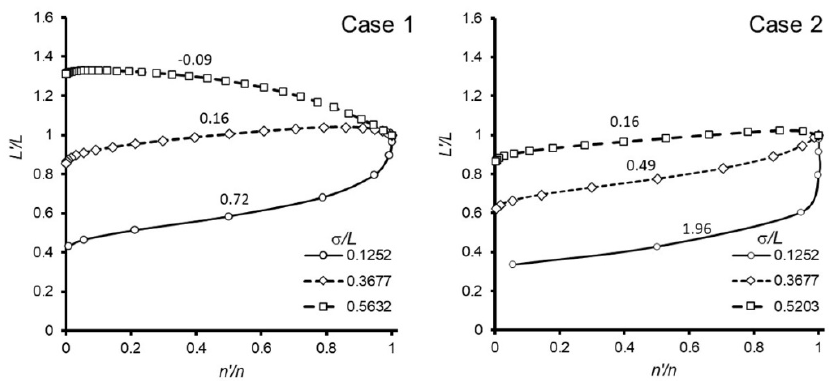
Figure 11. Relation between L ′ and n ′ in Cases 1 and 2. Numbers near each line are the average slopes ( dL / dn ).